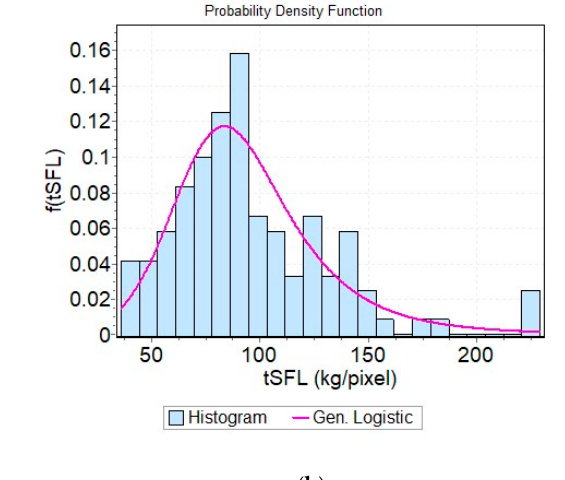
Figure 11. Nonlinear dependency of the surface fuel load estimation bias on the amount of observed surface fuel load. The transformed bias of the original lnfSFL-BioTopo model and the lntSFL-BioTopo model was positively related to the values of fSFL ( a ) and tSFL ( b ).